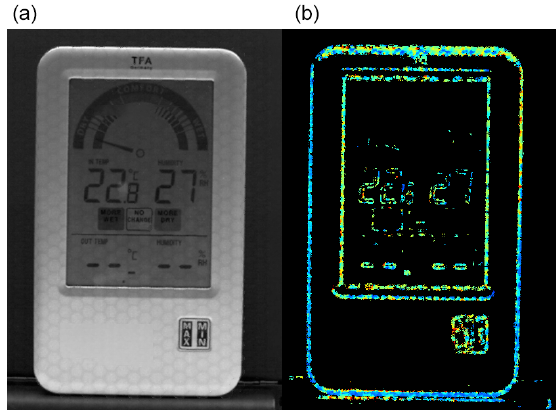
Figure 26. Case recorded by the plenoptic camera. Intensity (a) im- age and depth map (b) calculated from the recordings of the plenop- tic